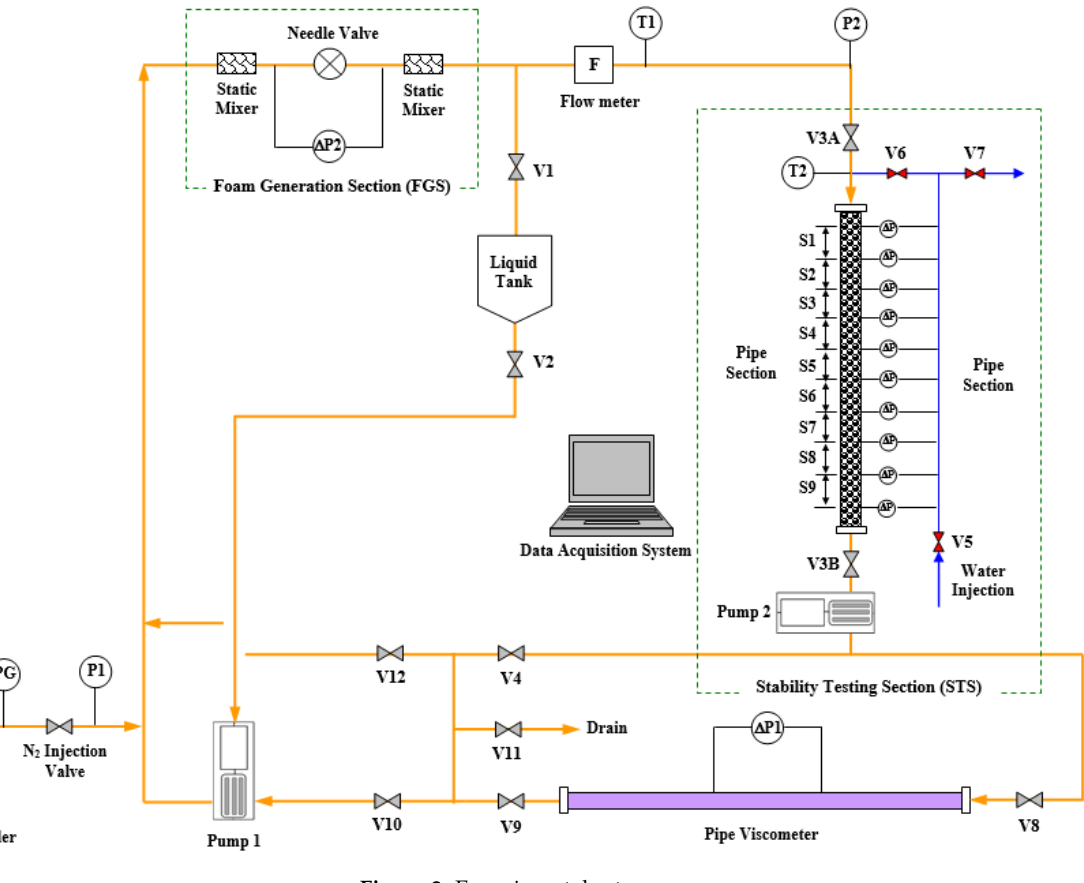
Figure 2. Experimental setup.